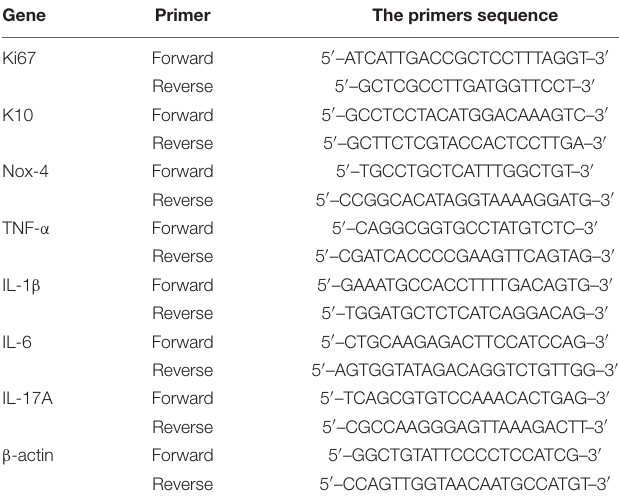
TABLE 1 | Primer Sequences Used for